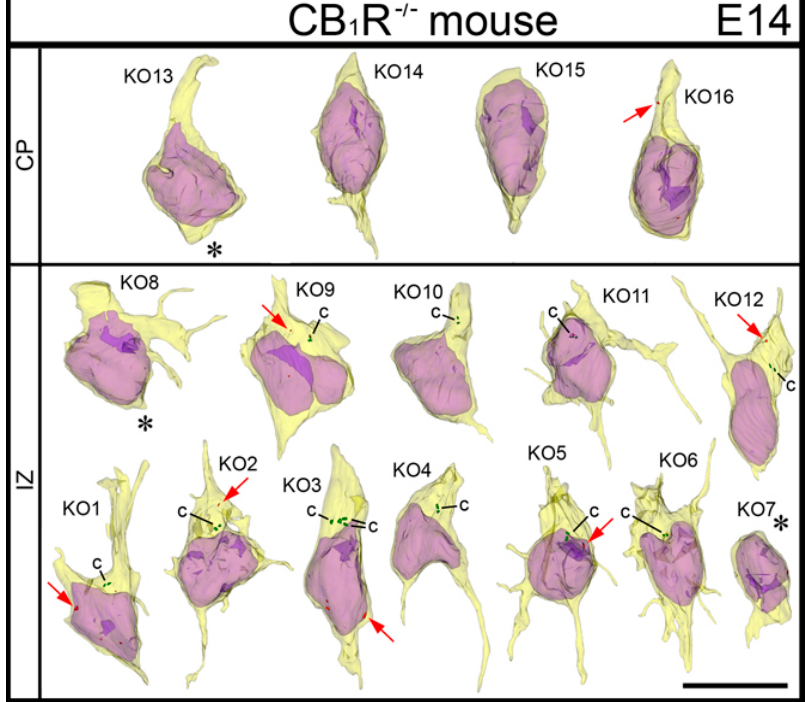
Figure 11. Montage of 3D reconstructed cells from indicated neocortical zones of E14 CB 1 R − / − mouse embryos. The cells are placed with pia-directed segments up and the segments facing the ventricular surface down. Reconstructed cell bodies with proximal segments of processes are shown as semitransparent yellow, and nuclei are semitransparent violet. Most of the identified processes are incompletely reconstructed because of truncation in the serial sections. Short processes or cell body segments indicated with asterisks are terminated in the analyzed serial sections. Most of the cells show multipolar shape designating deviations from normal radial migration. Rare non-selective anti-CB 1 R-L31 immunoreaction end-product depositions are shown as red and pointed with red arrows. Indexes of the cells correspond to Supplementary Table S2 that qualitatively and quantitatively characterizes each cell. Cell KO3 contains four centrioles (c; depicted green) that identify duplication of the centrosome during early prophase of mitosis. Scale bar (10 µ m) is valid for all the cells.